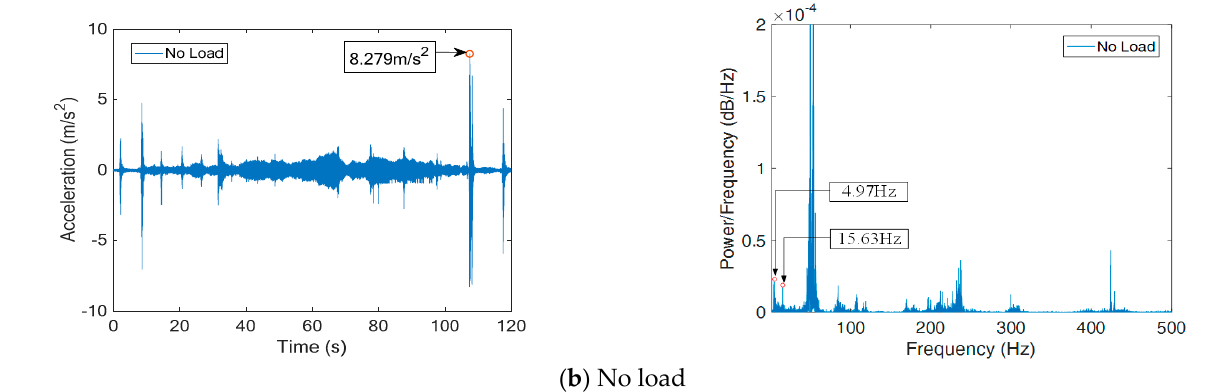
Figure 8. Effects of vehicle load on the vertical acceleration of suspension bogie.